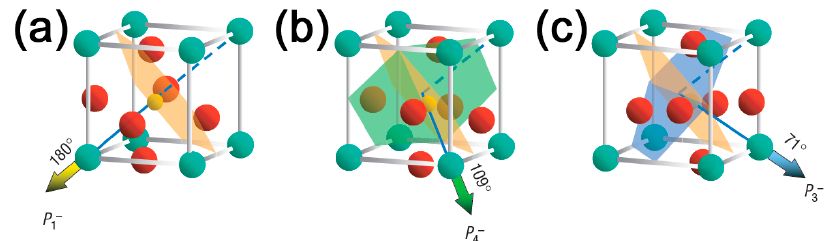
Figure 5. The schematic diagram of (001)-oriented BiFeO 3 crystal structure and direction of the spontaneous polarization corresponding to the ( a ) 180°; ( b ) 109° and ( c ) 71° domains. Adapted from [88], with permission from © 2006 Nature Publishing Group.